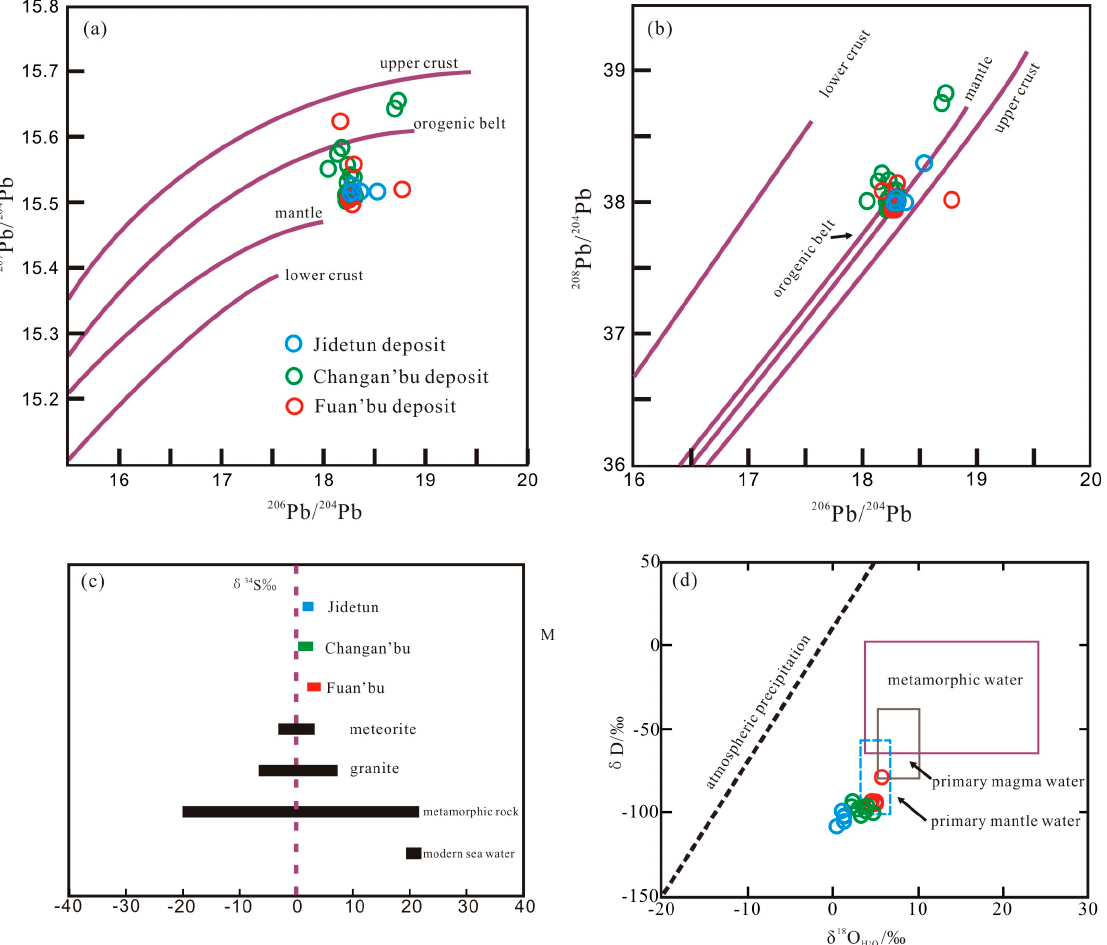
Figure 8. Pb and S source diagram for sulphides. δ D versus δ 18O H2O discrimination diagram for fluids from the Chang’anbu, Fu’anbu, and Jidetun deposits [34–36]. ( a ) 206Pb/204Pb-207Pb/204Pb; ( b ) 206Pb/204Pb-208Pb/204Pb; ( c ) δ 34 S content discrimination; ( d ) δ 18 O H2O - δ D.